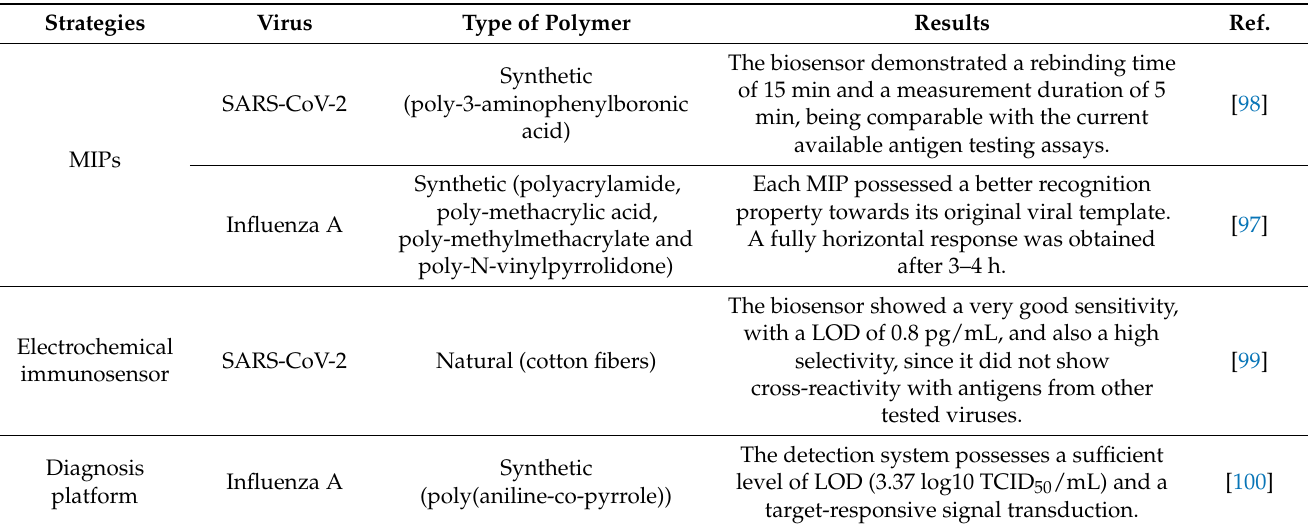
Table 2. Polymer-based strategies applied in the detection of SARS-CoV-2 and influenza A